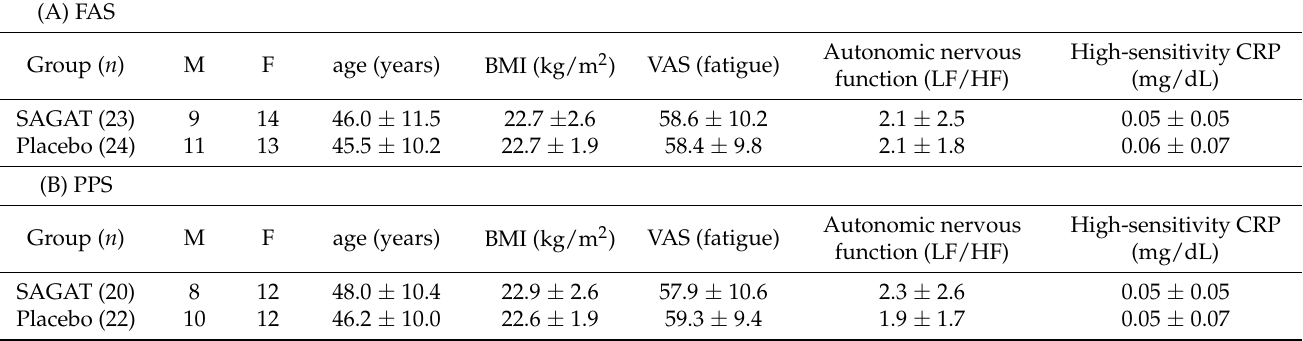
Table 1. Backgrounds of the